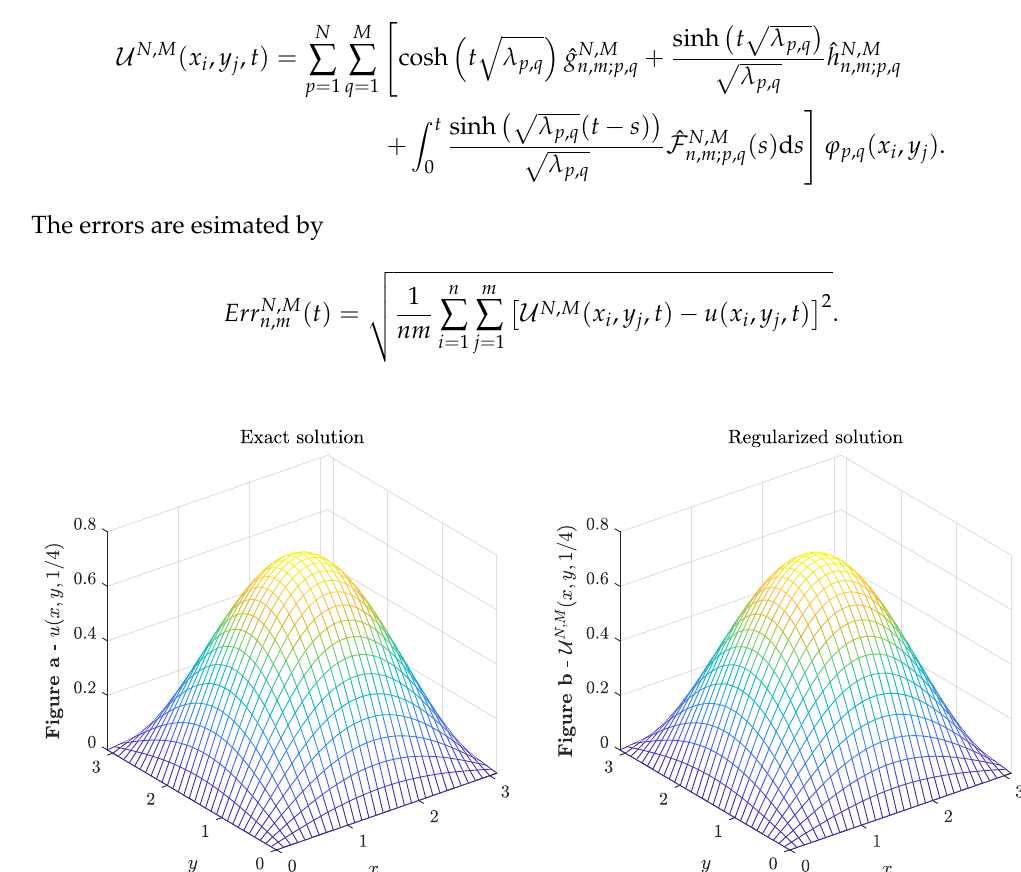
Figure 2. 3D graphs of exact solution at time t = 1/4, and the regularized solution for the regularization parameters of N = M = 3 and n = m =